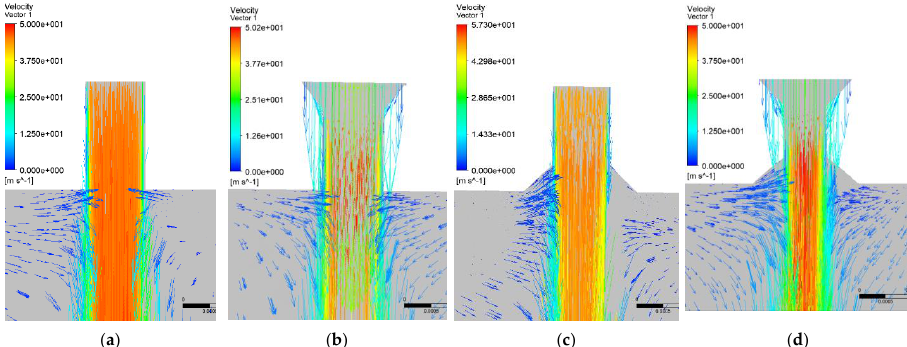
Figure 12. Velocity cloud image of the suction hole section. ( a ) Cylindrical-shaped suction hole; ( b ) Funnel-shaped suction hole; ( c ) Horn-shaped suction hole; ( d ) Diabolo-shaped suction hole.